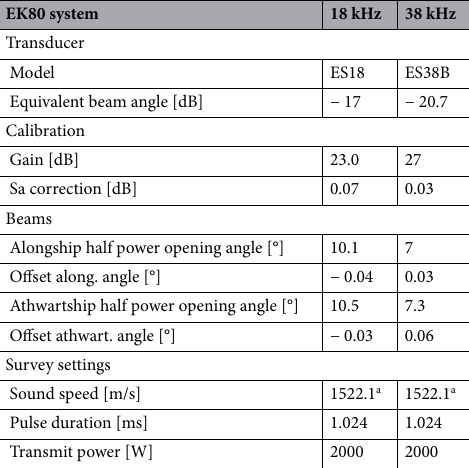
Table 1. Hull-mounted EK80 system settings and calibration parameters on R/ V Kronprins Haakon . a Before 3 May 23 UTC it was